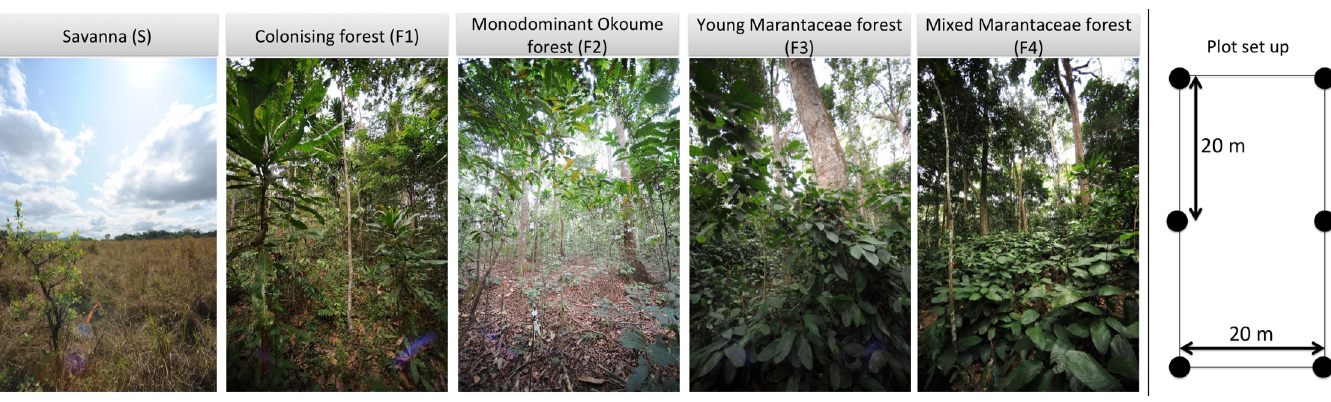
Fig 2. Different forest types (left) and plot set up